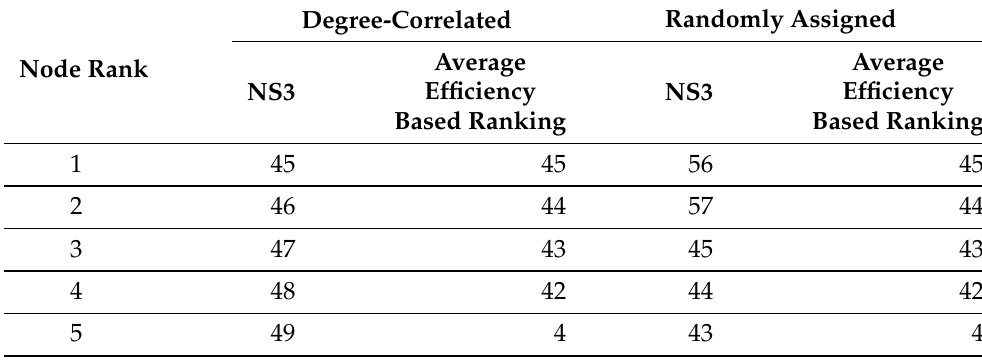
Table 5. Node raking comparison in random topology, based on average efficiency, when the node fitness is distributed in a degree-correlated and a random